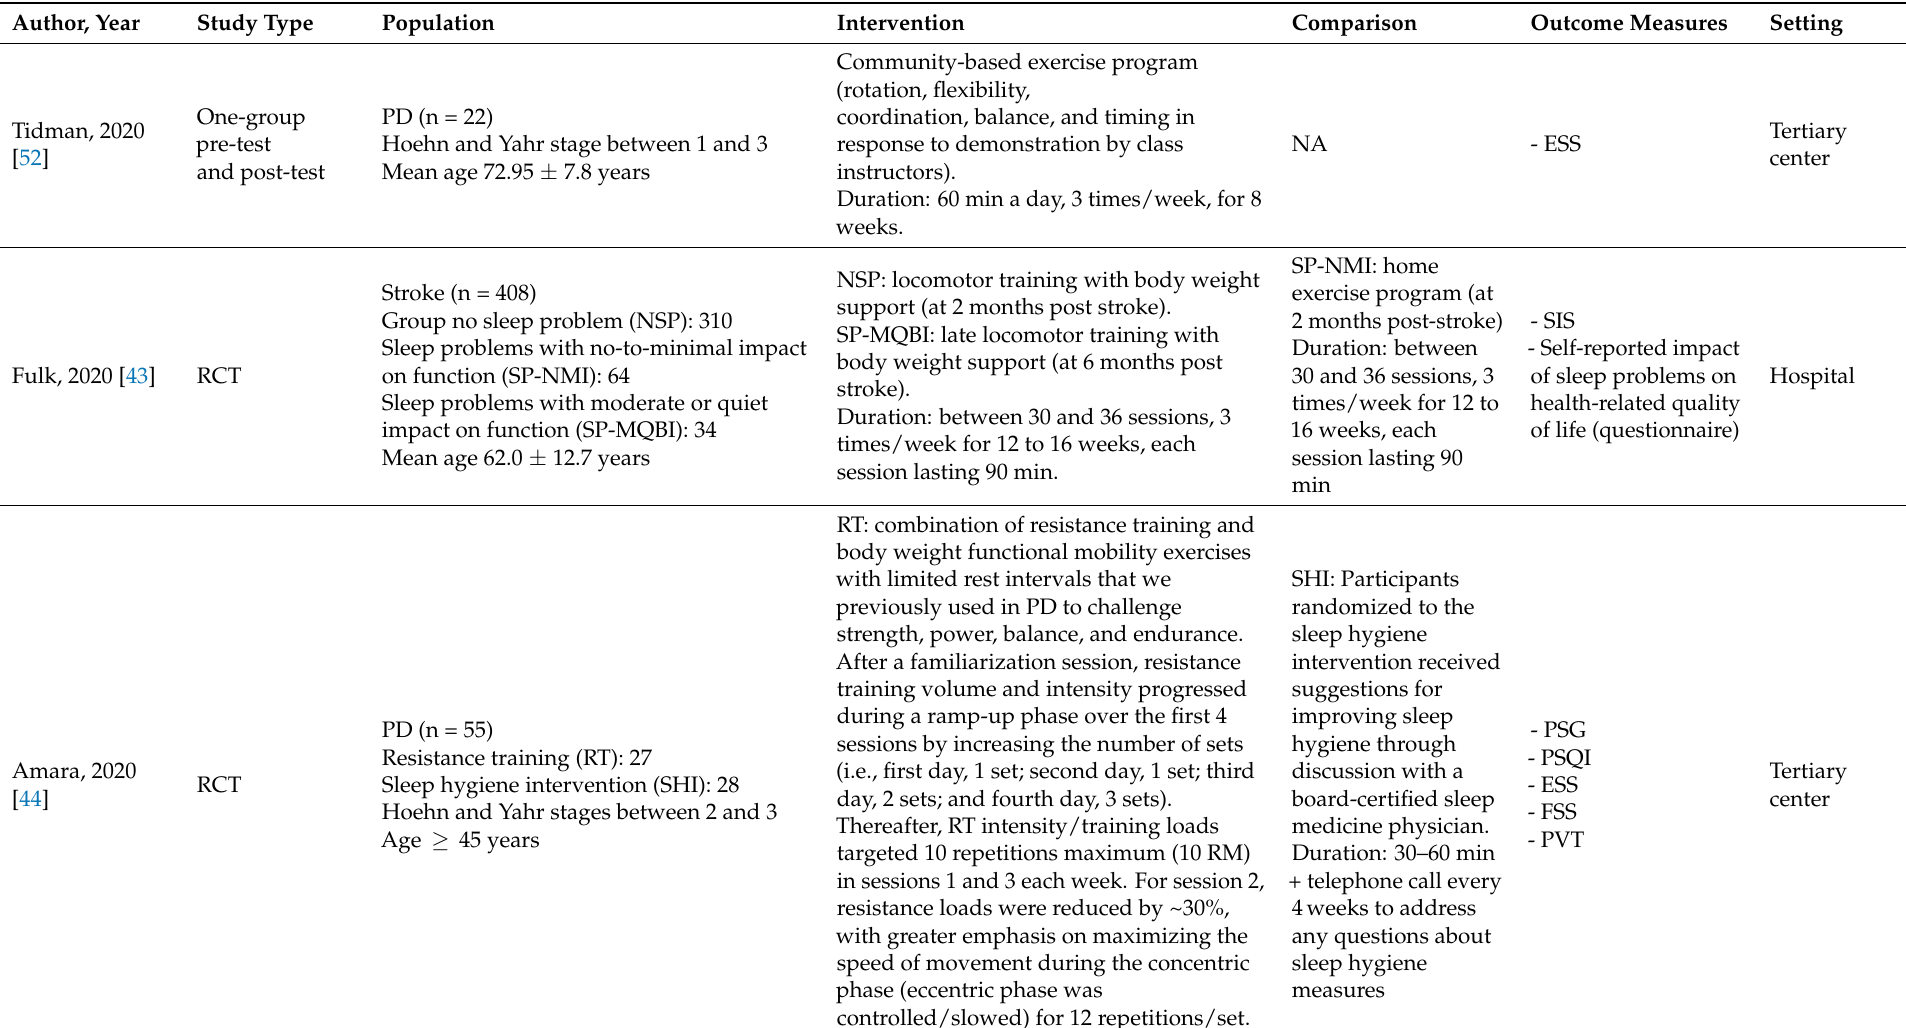
Table 1. Included studies according to the PICO